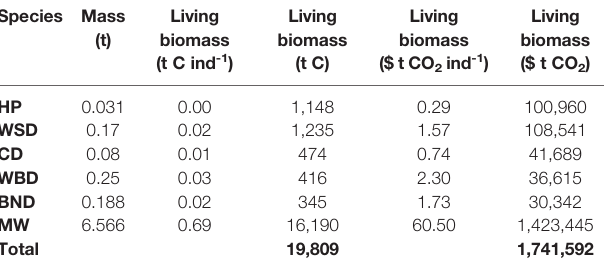
TABLE 3 | Stocks and valuations of carbon in living